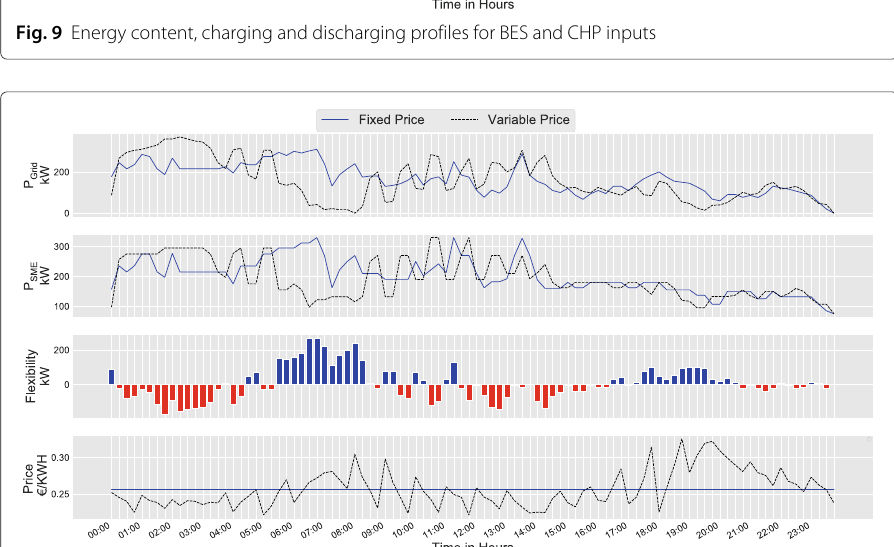
Fig.10 Load profile, power exchange with the grid and flexibility in both fixed and variable prices mechanism